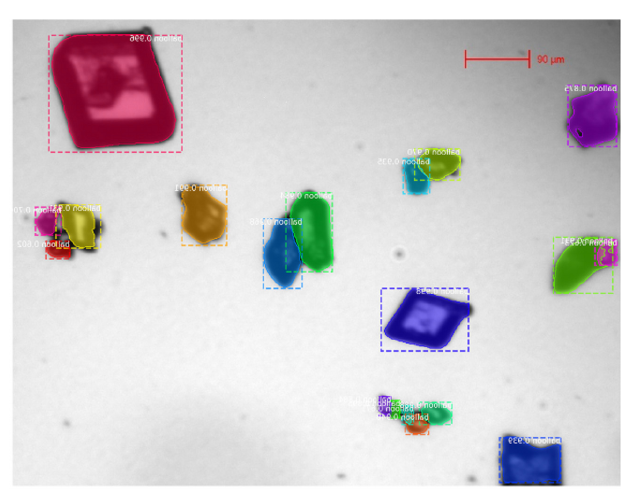
Figure 4. Output results of Mask R-CNN.